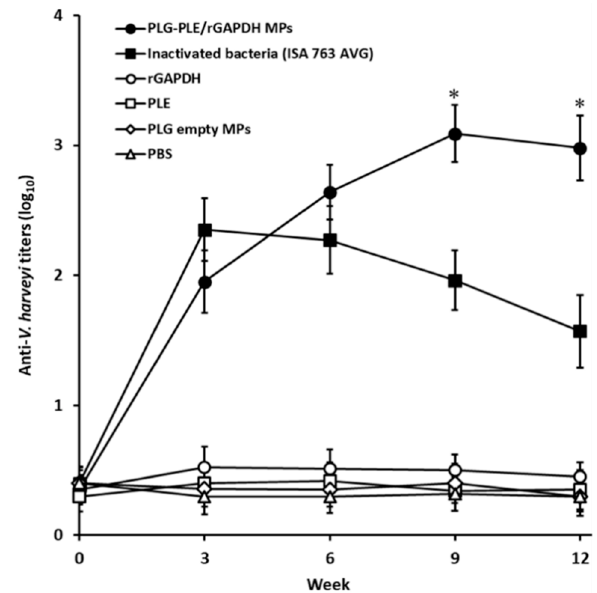
Figure 2. Anti- V. harveyi serum titers of vaccinated grouper. Six groups of grouper were peritoneally vaccinated with a single shot of PLG-PLE/rGAPDH MPs ( ● ), a single shot of inactivated bacteria (ISA 763 AVG) ( ∎ ), a single shot of rGAPDH ( ○ ), a single shot of PLE ( □ ), a single shot of PLG empty MPs ( ◊ ) or a single shot of PBS ( ∆ ). Following peritoneal vaccination, anti- V. harveyi serum titers of different groups were examined by ELISA every three weeks. Results were expressed as the mean of log 10 titers ± standard deviation (SD). * A significant difference ( p < 0.05) exists when comparing the PLG-